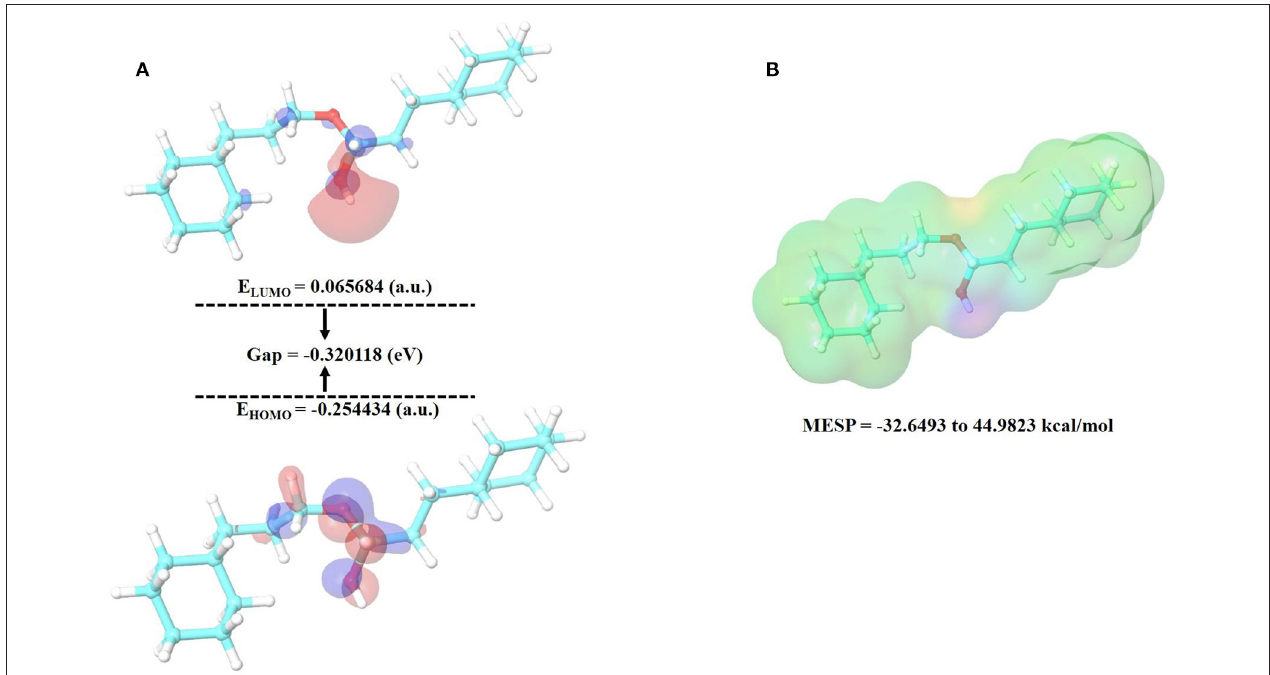
FIGURE 9 | (A) HOMO, LUMO and (B) MESP of cinnamyl dihydrocinnamate (CMNPD5348).